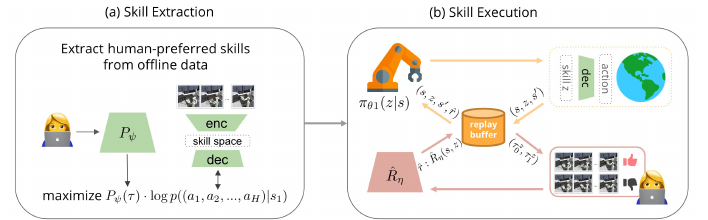
Figure 10. Skill preferences (SkiP) [166] consists of two phases. During the skill extraction phase, human feedback is used to learn skills. During the skill execution phase, human feedback is used to finetune the skills to solve various downstream tasks. First, skills are extracted from a noisy offline dataset with human feedback to denoise behavioral priors. Second, skills are executed with RL in the environment with task-specific human